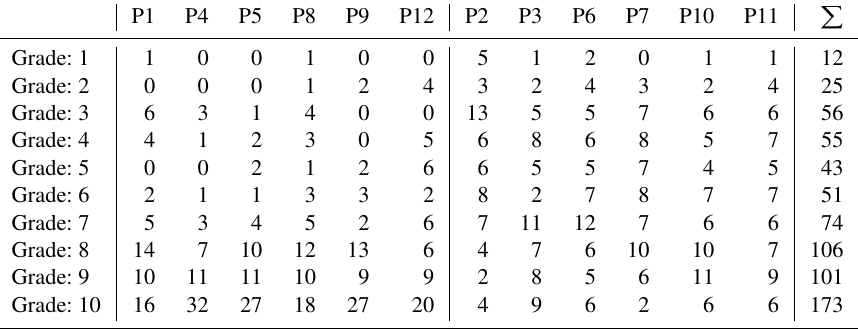
Table A2. Frequencies of ratings by non-geoscientists for all pictures. The first six columns are the real pictures, the last six columns the BotW pictures.